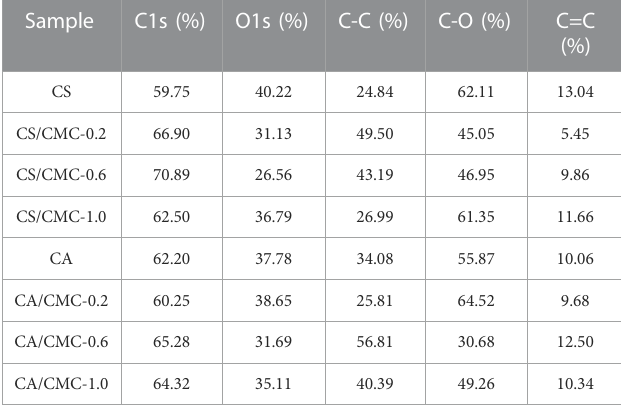
TABLE 2 Element proportion and chemical bond for the starch/CMC composite fi lms.